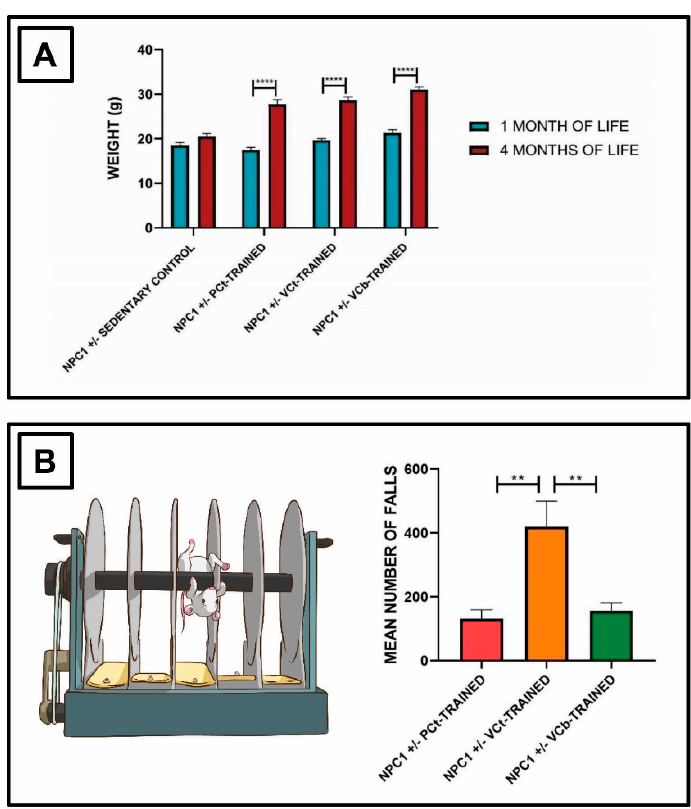
Figure 1. Effects of three different aerobic training protocols on physical and performance parameters. ( A ) The mean body weight in the control group was 18.5 ± 0.4 g at one month of life and 20.5 ± 0.4 g at four months of life. Regarding the trained mice, the mean body weight was 17.5 ± 0.5 g in the PCt group, 19.7 ± 0.3 g in the VCt group and 21.3 ± 0.7 g in the VCb group at one month of life. After training sessions, the mean body weight was 27.7 ± 1.0 g in the PCt group, 28.7 ± 0.7 g in the VCt group and 31.0 ± 0.6 g in the VCb group (**** p < 0.0001); ( B ) mean number of falls during the training